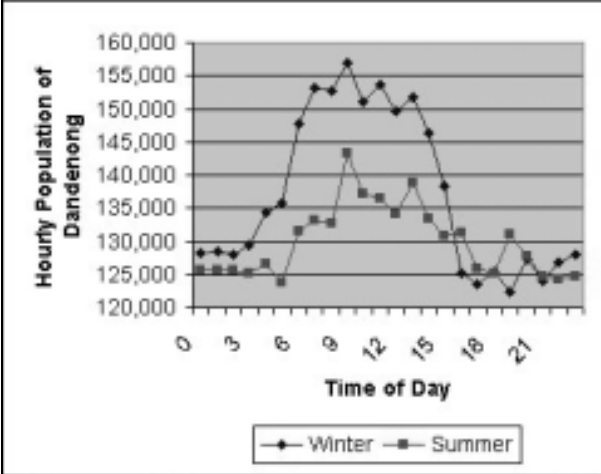
Figure 8. Seasonal variation in hourly population of Dandenong While the hourly population of Bayside attains its peak numbers in the evening hours between 7 pm and 3 am, the city of Dandenong has its crest during the day between 4 am and 6 pm when most stores, factories and businesses are open and workers and customers flock to the city. After 7 pm, the population returns to its residential levels. The highest hourly population reaches 157000 in summer but only 144000 in winter, again in contrast with Bayside which obtains its highest population in winter.